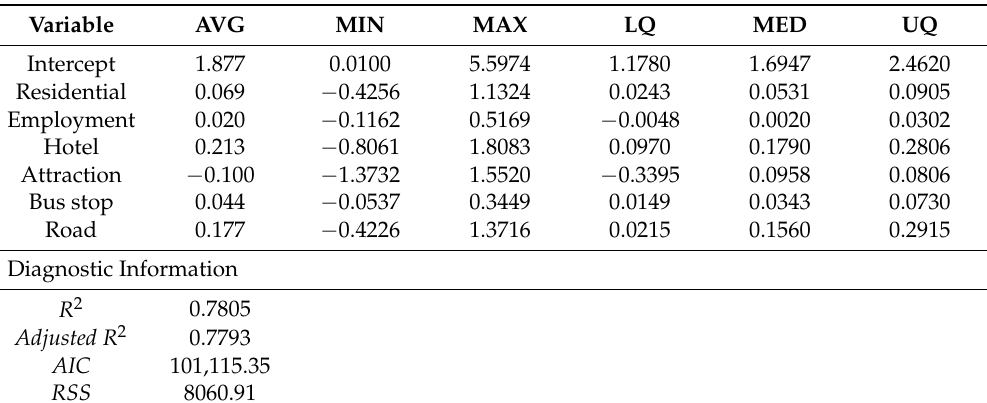
Table 4. Estimation of the GWR model.